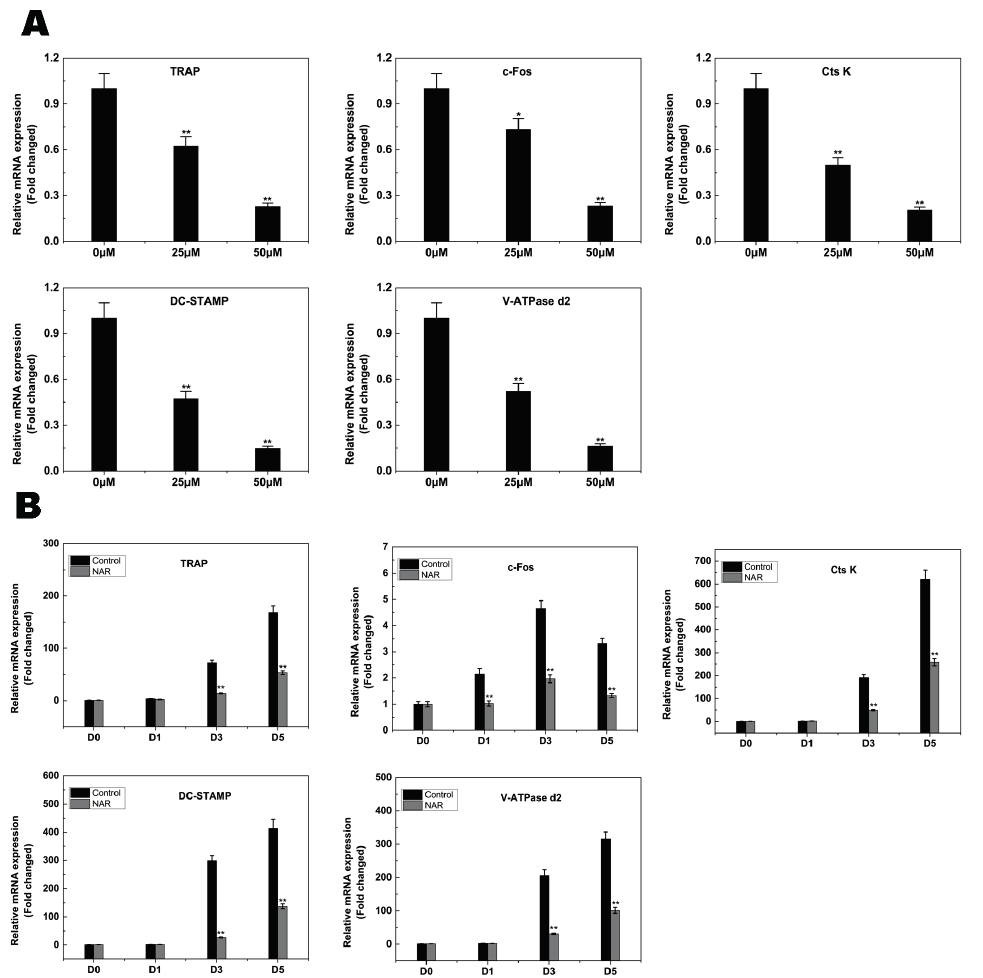
Figure 5. Naringenin (NAR) suppressed receptor activator of the nuclear factor- κ B ligand RANKL-induced expression of osteoclast-specific genes. Bone marrow macrophages (BMMs) were cultured with macrophage colony stimulating factor (M-CSF; 30 ng/mL) and RANKL (50 ng/mL), with or without NAR. The expression of c-Fos , TRAP , cathepsin K ( CtsK ), dendritic cell-specific trans membrane protein ( DC-STAMP ) and vacuolar-type H + -ATPase domain 2 ( V-ATPase d2 ) was analyzed by real-time quantitative polymerase chain reaction and the results were normalized to the expression of glyceraldehyde-3- phosphate dehydrogenase ( GAPDH ). ( A ) Levels of the indicated mRNAs following exposure to NAR (0, 25, or 50 μ M); ( B ) Levels of the indicated mRNAs following exposure to 50 μ M NAR for 0, 1, 3, or 5 days. All experiments were performed at least three times. * p < 0.05; ** p <